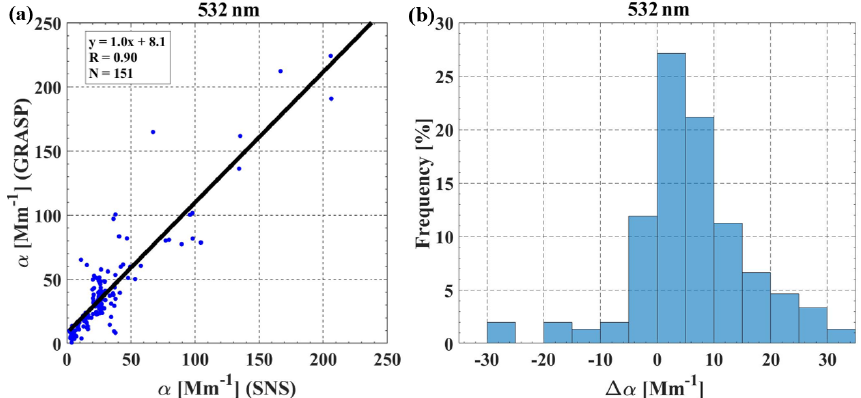
Figure 4. (a) Extinction ( α ) coefficient retrieved by GRASP at the SNS height versus the in situ measurements at the SNS and (b) the histogram of the absolute difference between GRASP and the SNS in situ measurements.